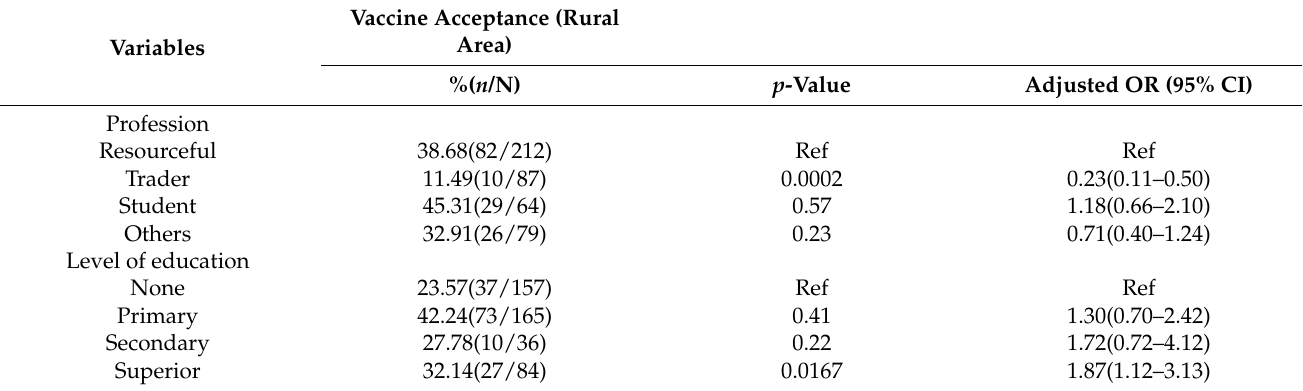
Table 5. Factors to acceptance of the vaccine against COVID-19 in a multivariate regression